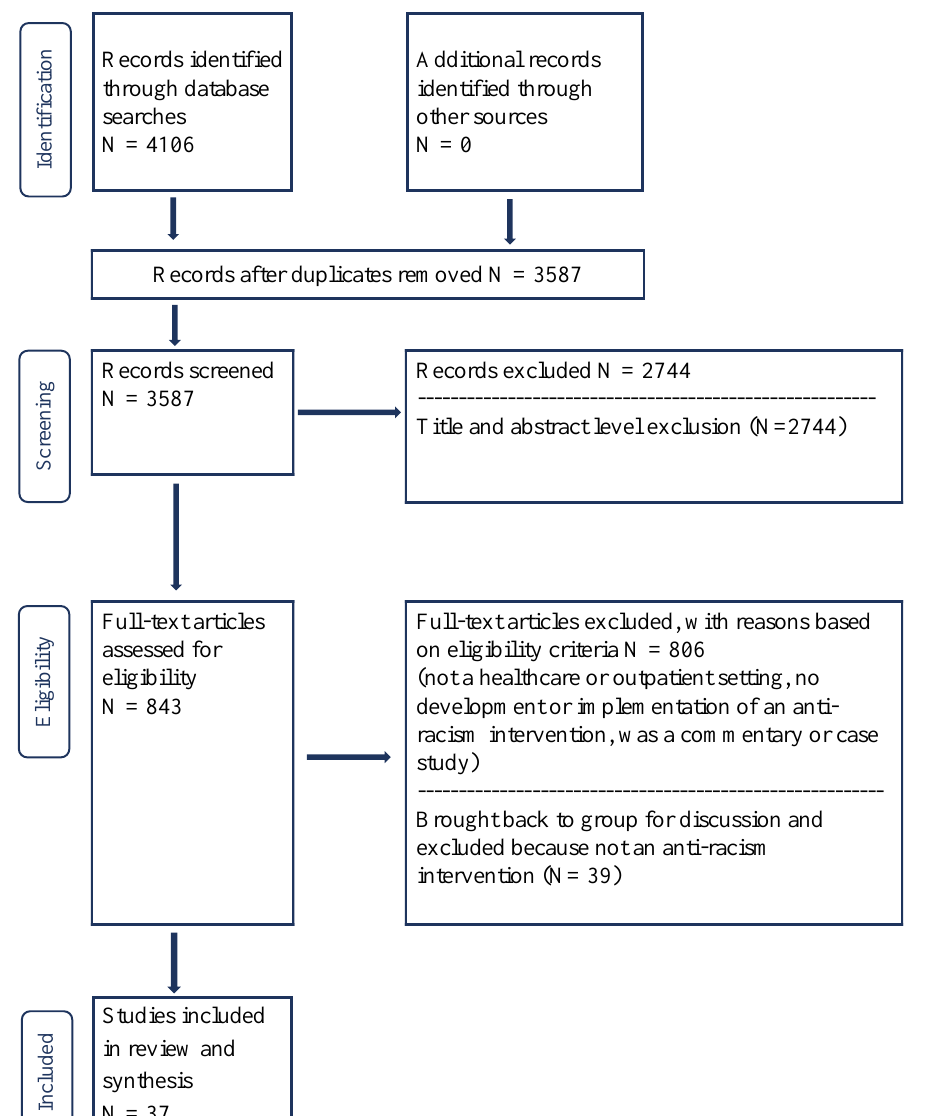
Figure 1. PRISMA flow diagram for peer-reviewed